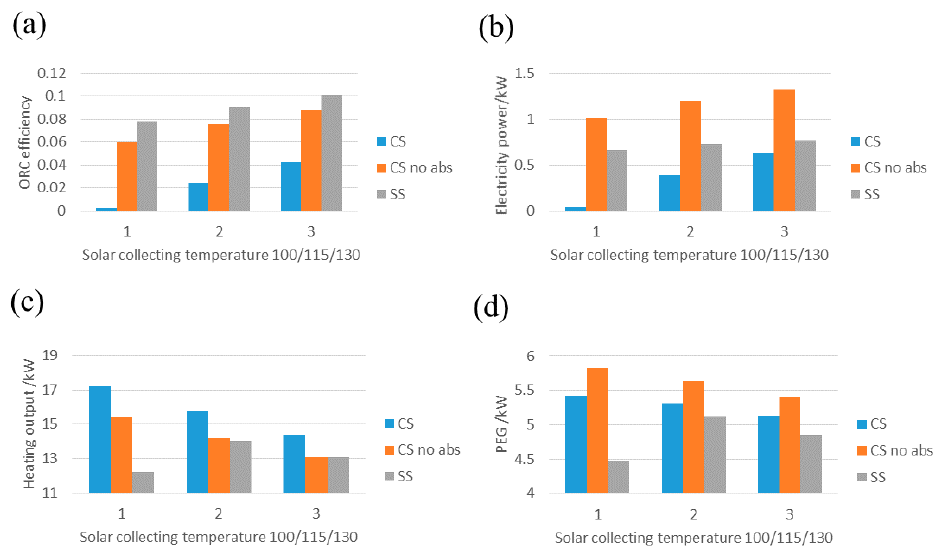
Figure 7. ( a ) ORC efficiency, ( b ) cooling output capacity, ( c ) electricity generation and ( d ) primary energy efficiency for the CCHP systems under different solar collecting temperature with R123 as ORC working fluids in heating mode.